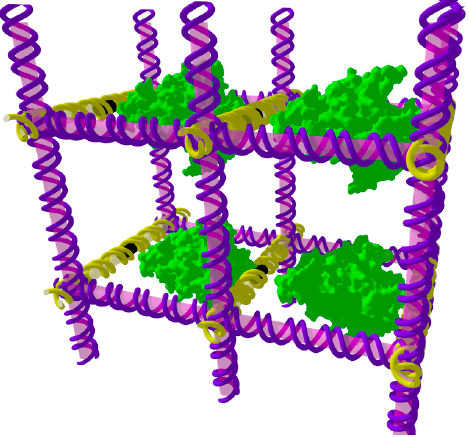
Figure 1. A periodic DNA scaffold. This schematic imagines that DNA (purple/yellow) could